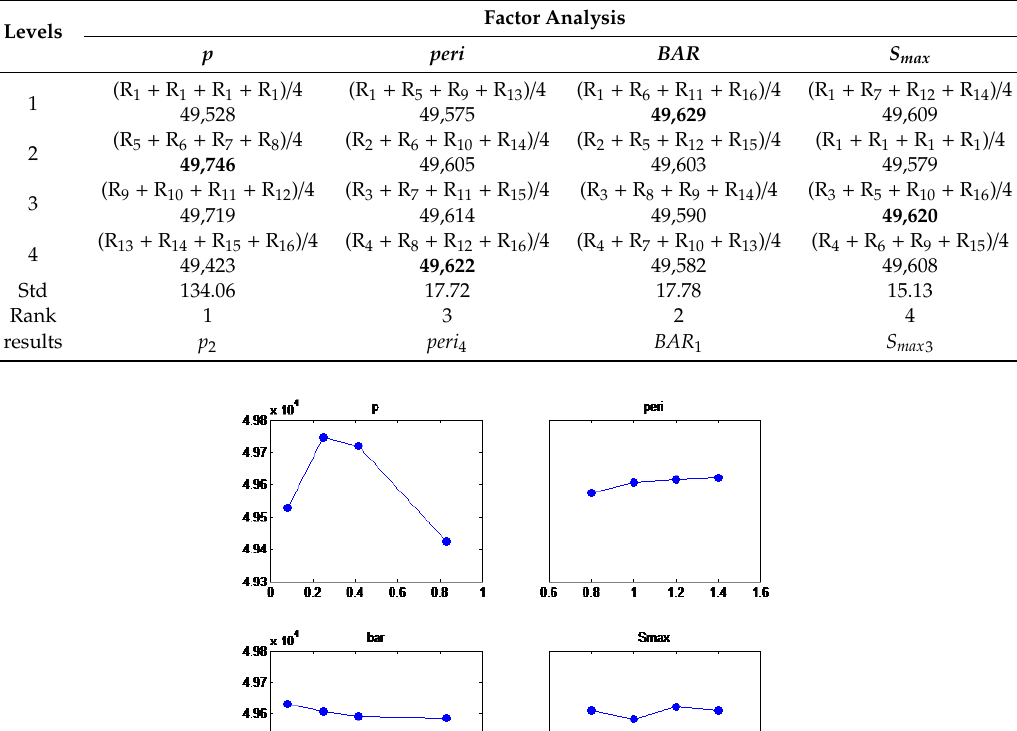
Table 3. Factor analysis with the orthogonal design (OD) method.